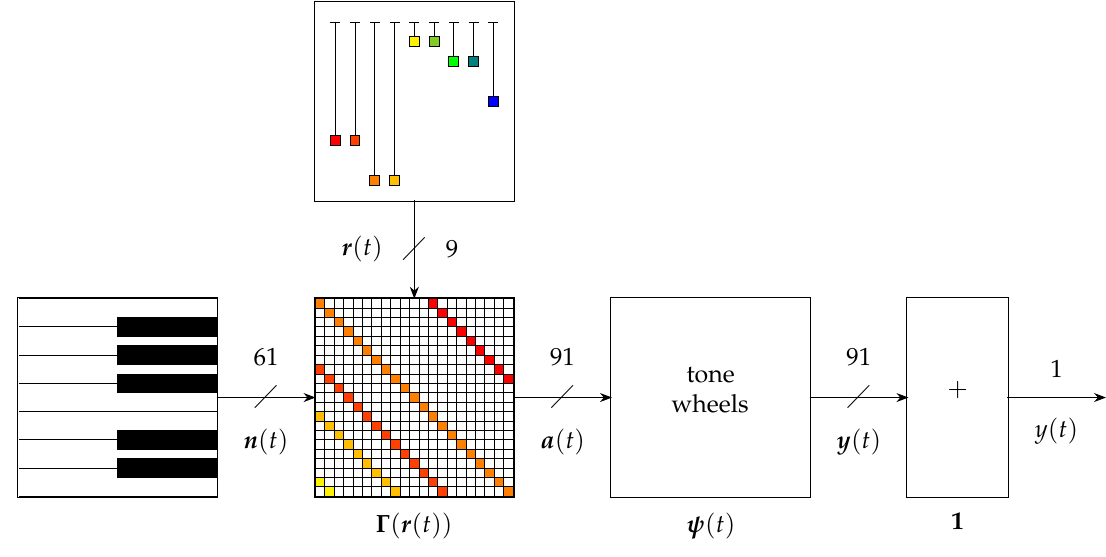
Figure 1. Hammond Tonewheel Organ block diagram.